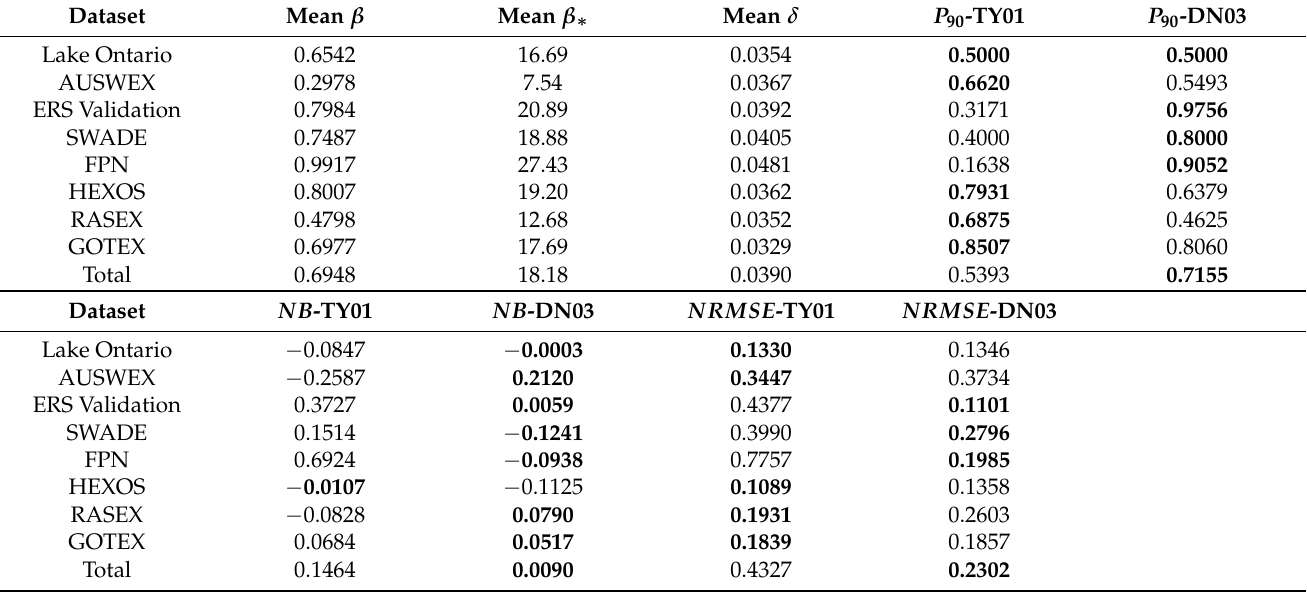
Table 4. P 90 , NB , and NRMSE predicted by TY01 and DN03 for each